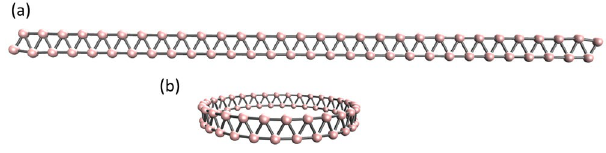
Figure 1. Structures of ( a ) l -BNR[2,30] and ( b ) c -BNR[2,30], each containing 30 boron atoms along the length or circumference of